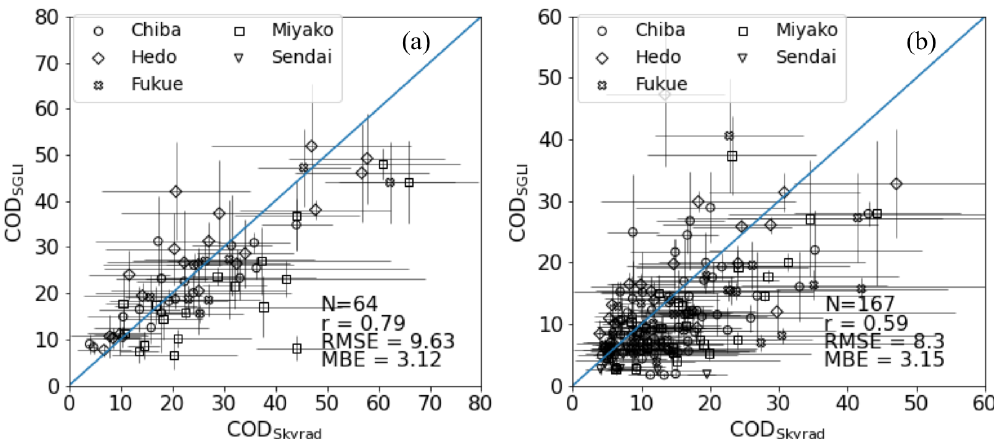
Figure 1. Comparison of COD between the sky radiometer and SGLI for (a) water clouds and (b) ice clouds for data collected over SKYNET